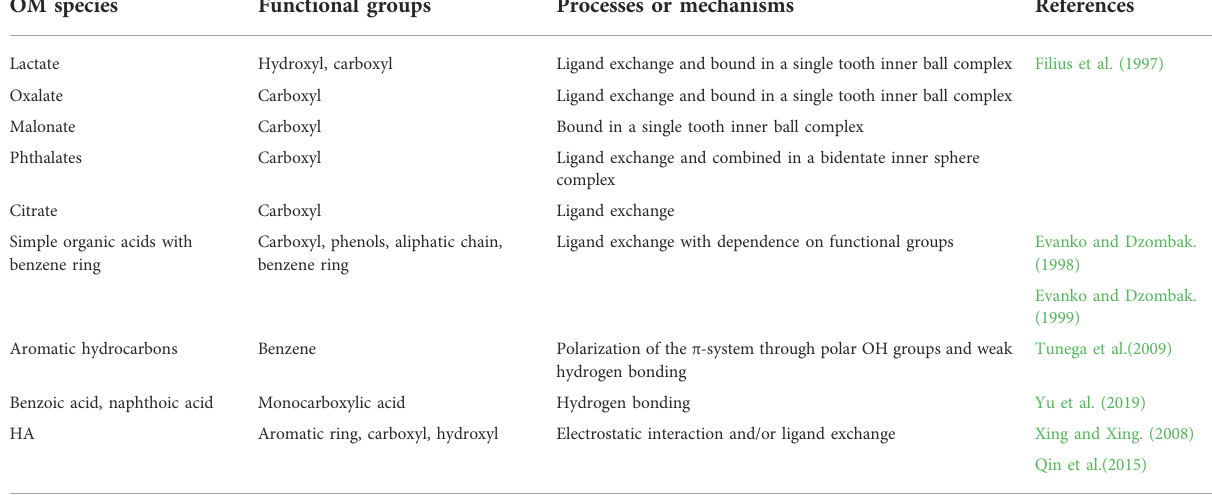
TABLE 1 Interaction processes and mechanisms of OM with